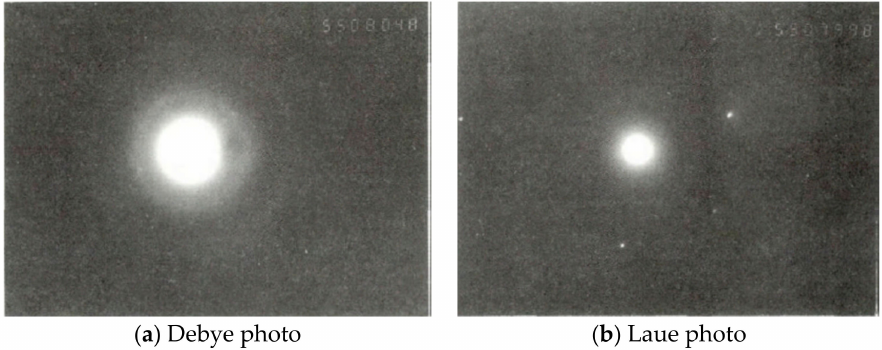
Figure 7. X-ray di ff raction picture of nanodiamond grain.